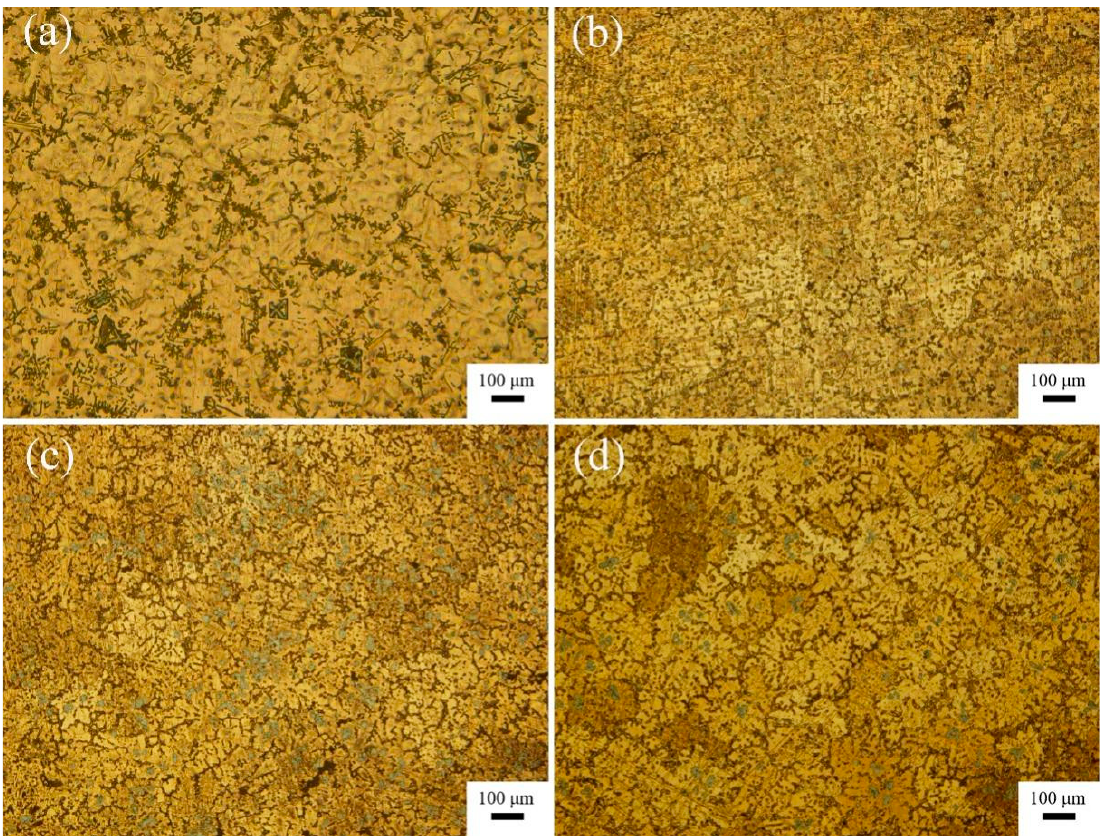
Figure 6. Metallographic photos of the alloys and composites showing the morphology of α -Mg grains: ( a ) M-AC, ( b ) 1-COM, ( c ) 3-COM, and ( d ) 5-COM.